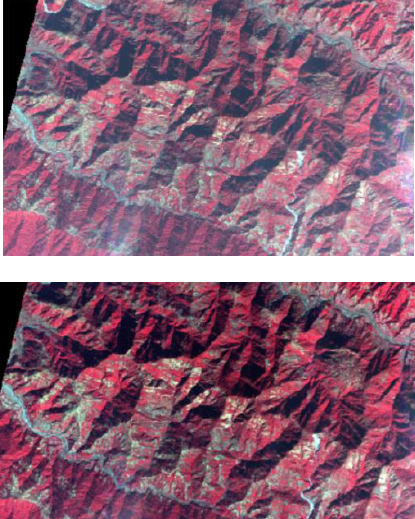
Figure 2. Image before (above) and after (below) atmospheric correction using COST